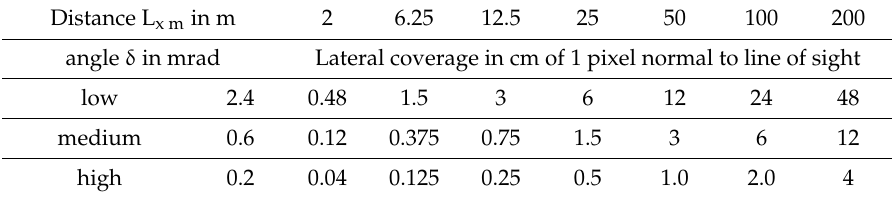
Table 2. One pixel covering δ mrad of angle means a lateral range in cm at a distance L x m